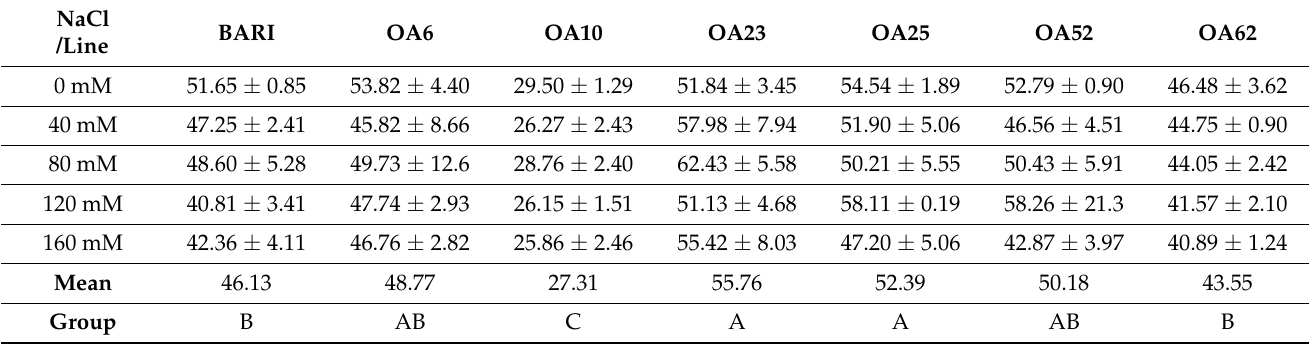
Table 1. Thousand kernel weight in grams after growth on different salt concentrations. The end of the table gives grouping information of the lines using the Games-Howell method and 95% confidence, n = 15. The means that are not sharing the same letter are significantly